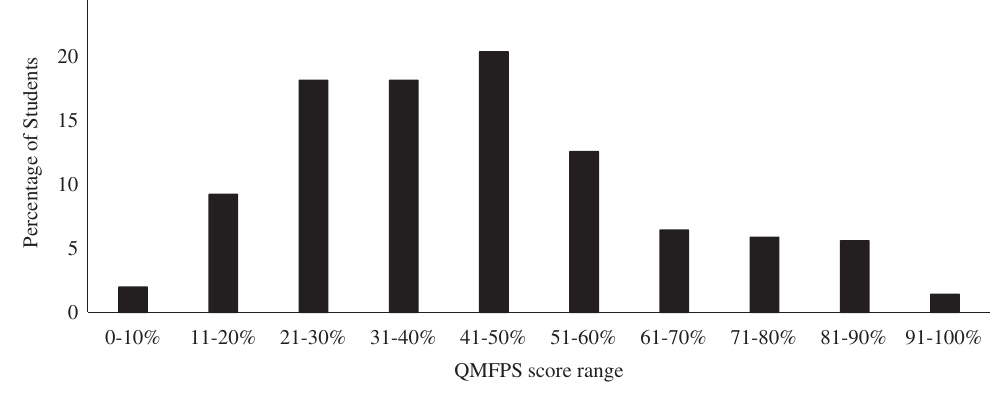
FIG. 1. Histogram of student scores on the